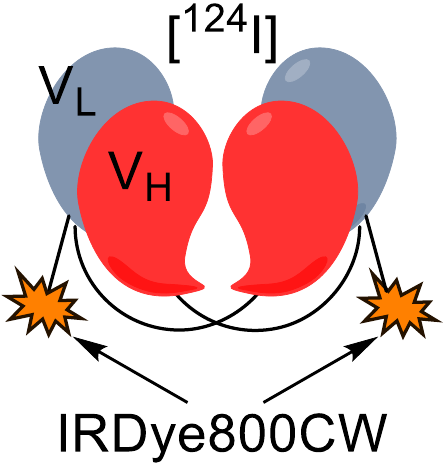
124 I-A2cDb-800 Figure 14. Diagram of 124 I-A2cDb-800 . Figure 14. Diagram of Figure 14. Diagram of 124 I-A2cDb-800 .